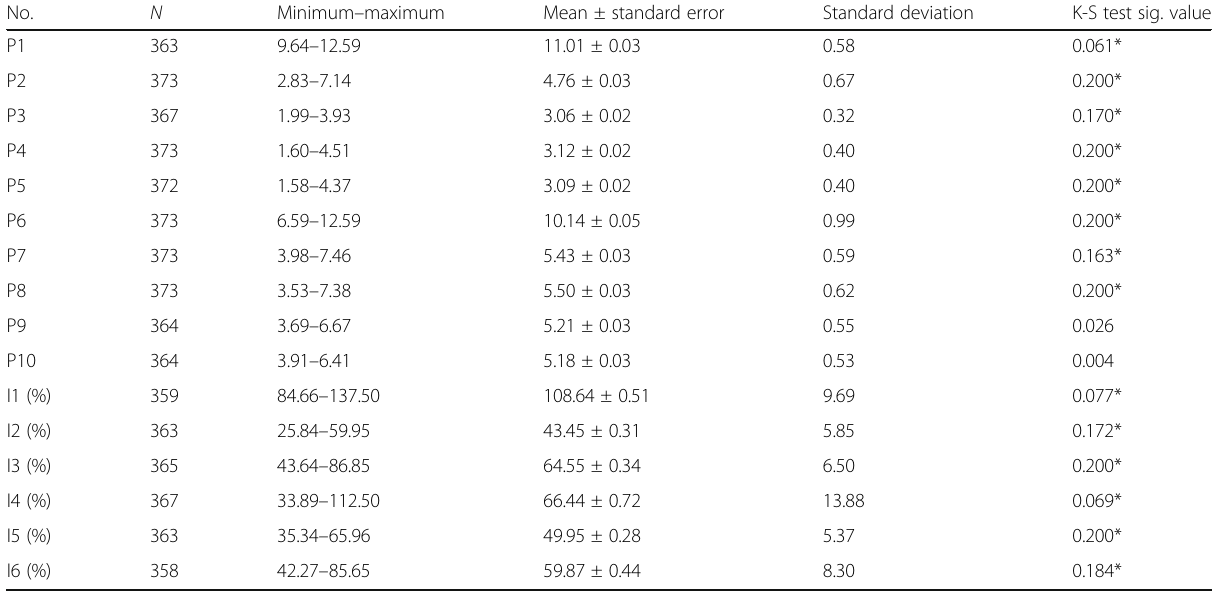
Table 5 Descriptive statistics for parameters and indices of sacral morphometric No. N